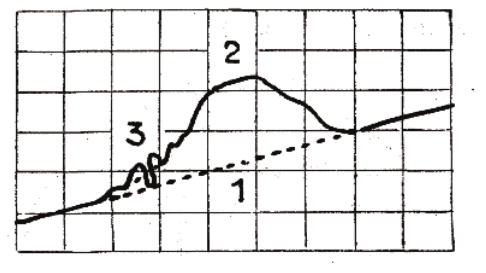
Figure 2. Schéma de bp .